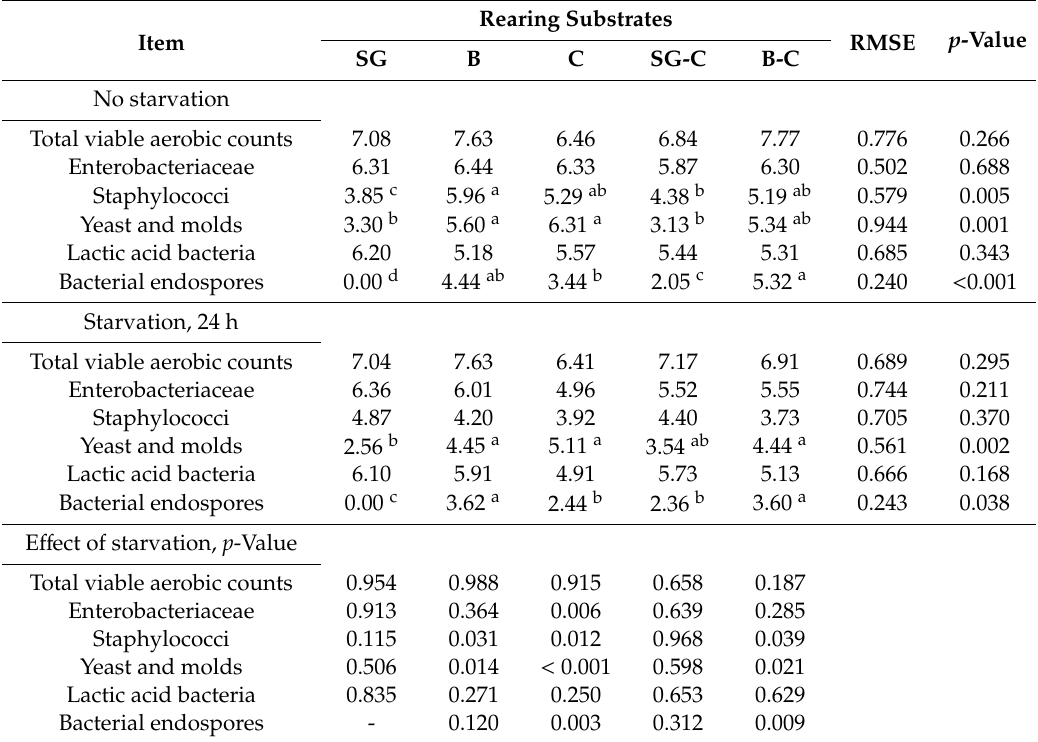
Table 3. Microbiological analyses of the larvae (un-starved and starved) reared on the di ff erent